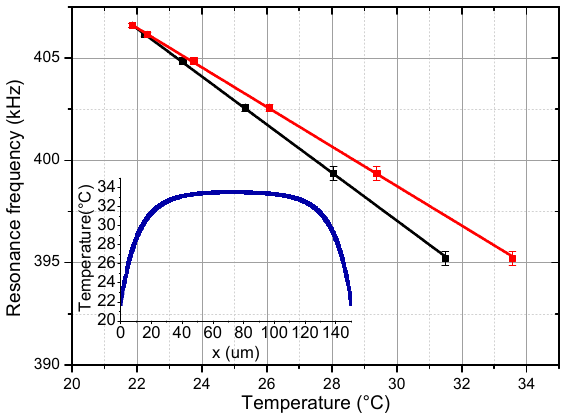
Figure 4. Resonance frequency (first flexural mode) of a LSMO bridges of dimensions 150 × 15 × 0.3 μ m 3 obtained as a function of calculated maximum (red) and average (black) temperature applied by Joule heating. Inset shows the temperature distribution calculated along the length of the